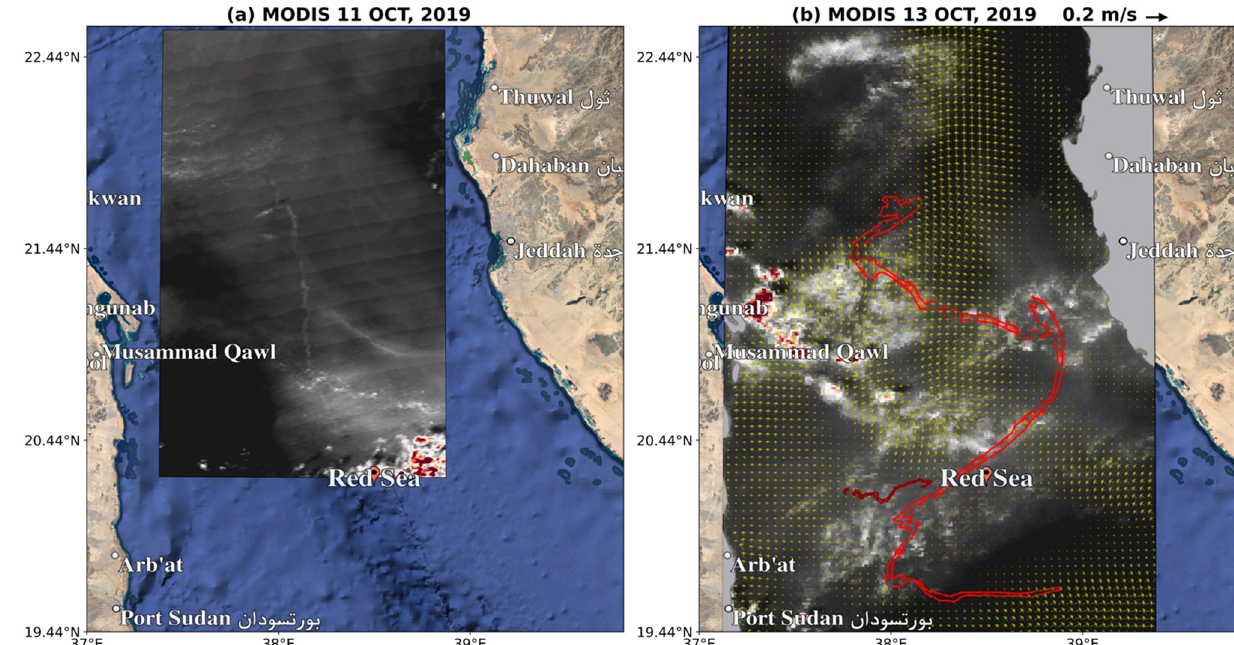
Figure 6. MODIS FEI images on ( a ) 11 October 2019 (the day of the accident); ( b ) the vectors overlaid on the MODIS image of 13 October 2019 (two days after the accident) are the model surface currents corresponding to the same day. The red line indicates the outline of the oil slick from Sentinel ‐ 1 SAR at 03:30 UTC on 13 October 2019.